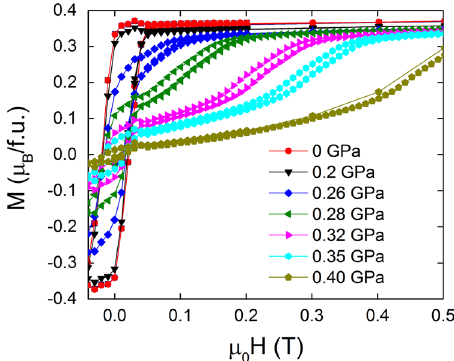
Fig. 7 Pressure dependence of the magnetization step Δ M at the metamagnetic transition and remnant magnetization M r at two selected temperatures for the UCo 0.990 Ru 0.010 Al sample for fi eld applied along the c -axis. The error bars indicate the uncertainities of derived quantities